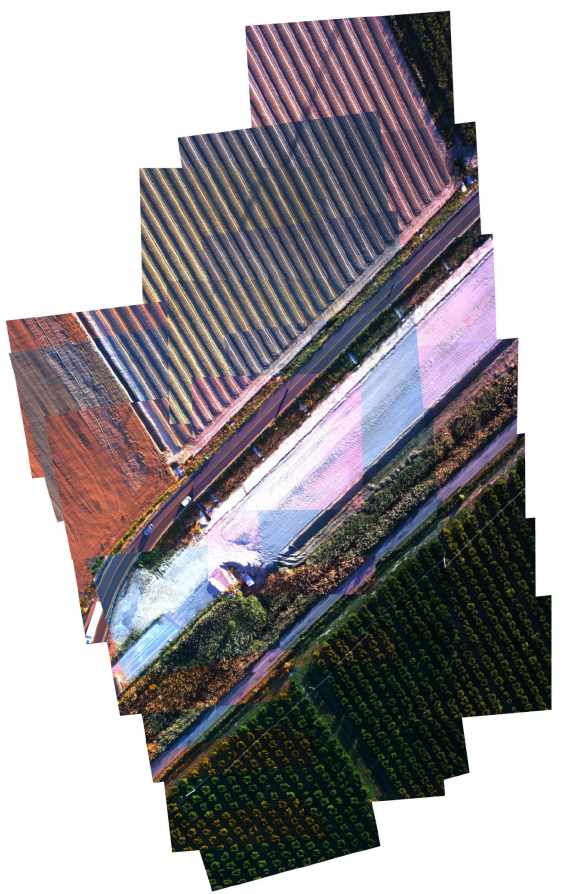
MOSAICO BASE Figure 7. Dataset 1: Mosaic obtained after image alignment, with no colour correction and seamline